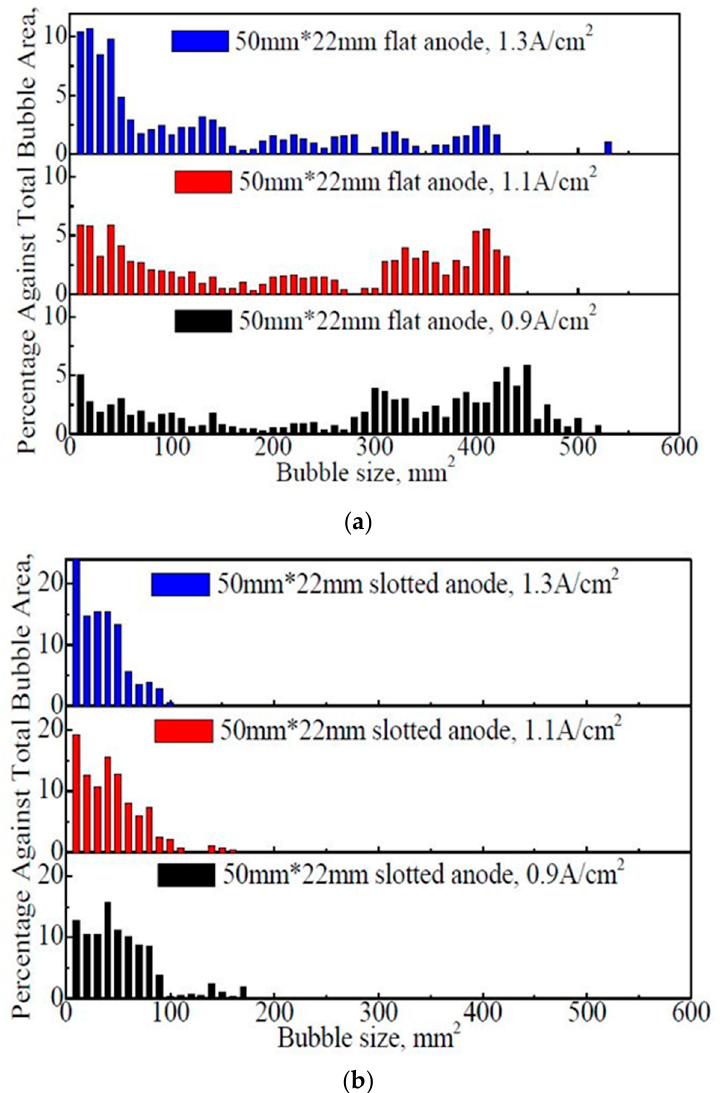
Figure 5. The size distribution of the bubbles on the flat and slotted anodes within 60 s. ( a ) 50 mm × 22 mm flat anode ( b ) 50 mm × 22 mm slotted anode.